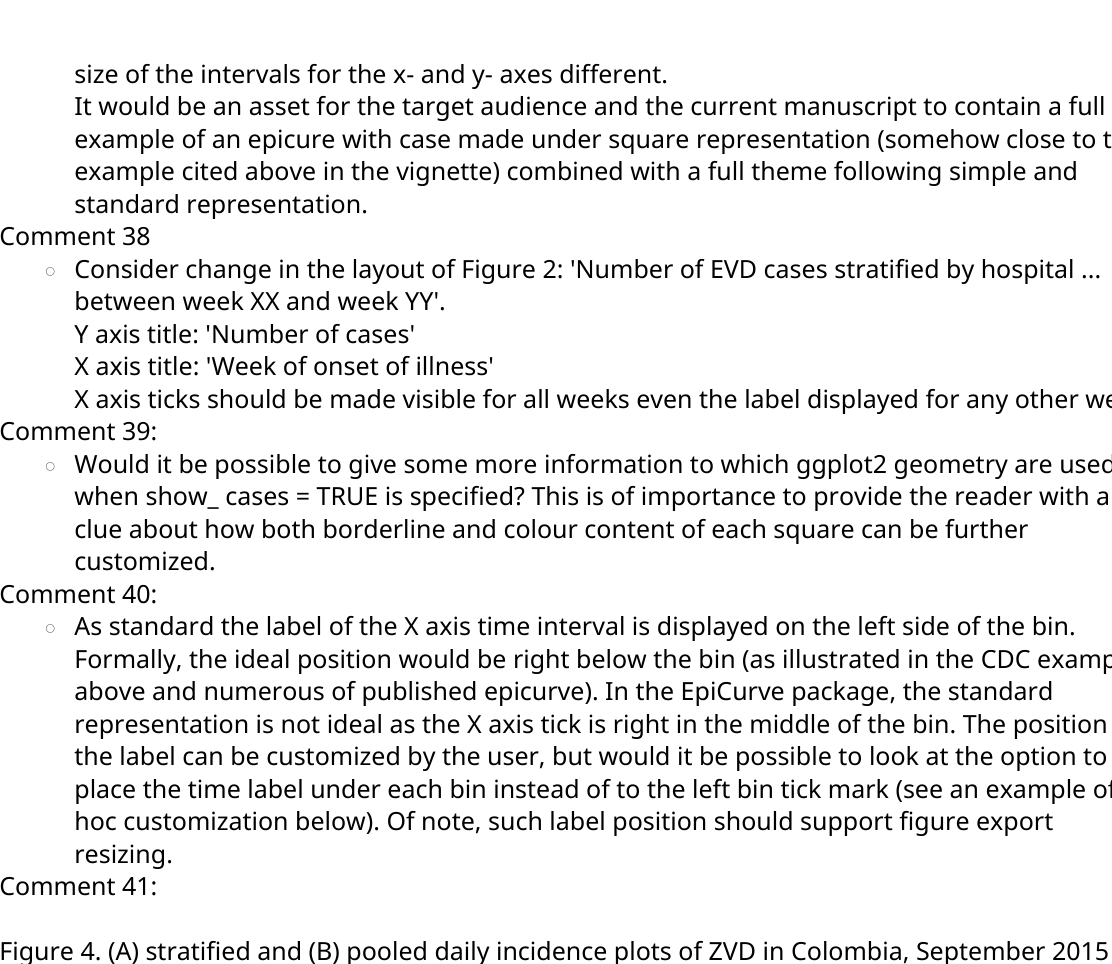
Figure 4. (A) stratified and (B) pooled daily incidence plots of ZVD in Colombia, September 2015 to January